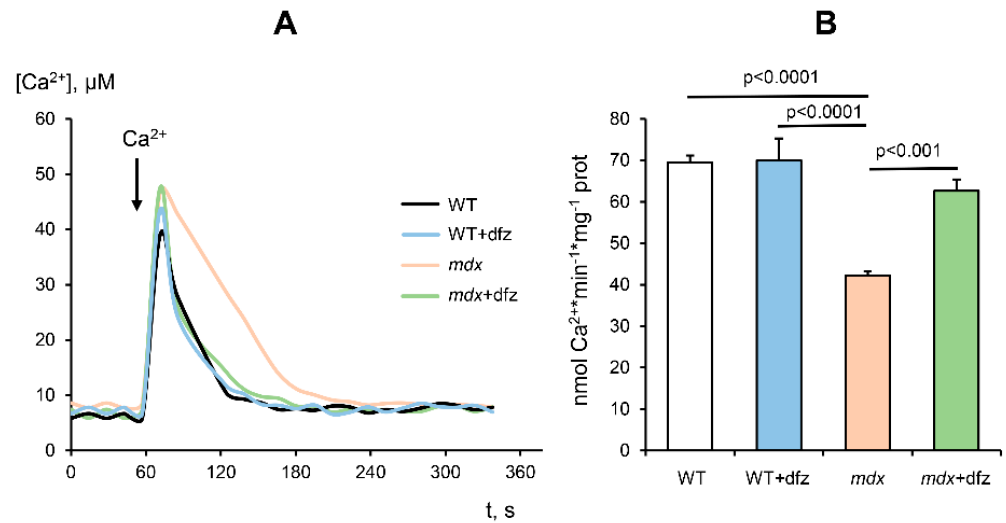
Figure 5. The dynamics of Ca 2 + uptake by skeletal-muscle mitochondria of studied groups of mice ( A ). Incubation medium: 210 mM mannitol, 70 mM sucrose, 2.5 mM glutamate, 1 mM KH 2 PO 4 , 50 μ M arsenazo III, 10 µ M EGTA, 2.5 mM malate, 1 µ M cyclosporin A, 10 mM Hepes / KOH, pH 7.4. Additions: skeletal-muscle mitochondria (0.4–0.5 mg / mL), 50 µ M CaCl 2 . The figure shows typical